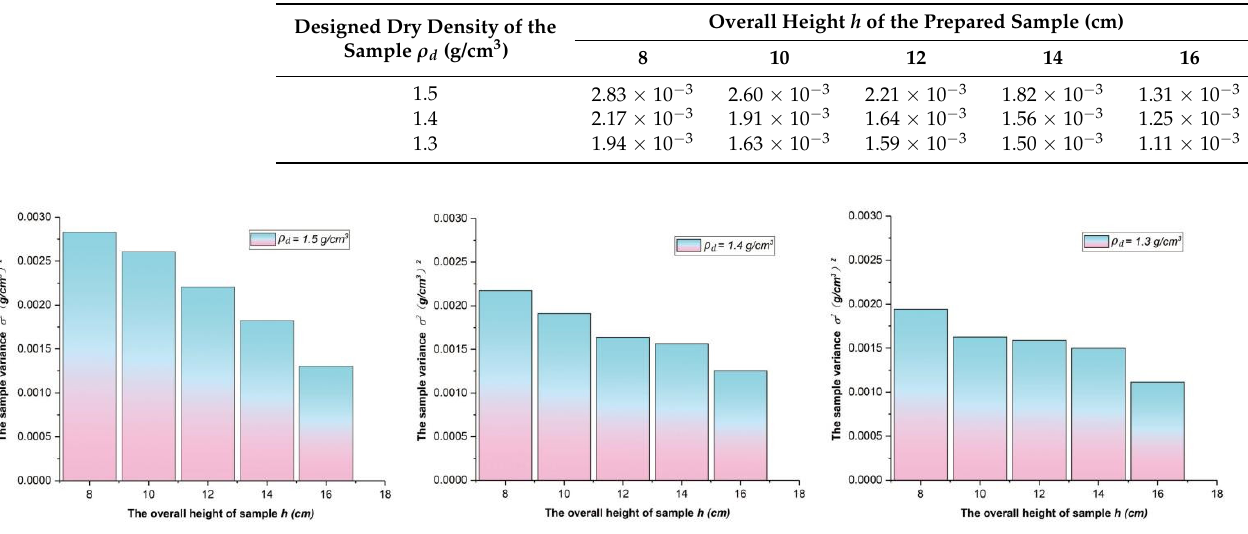
Figure 7. The variance in the dry densities of the stratified samples. Table 3. The variance in the dry densities of the stratified samples.